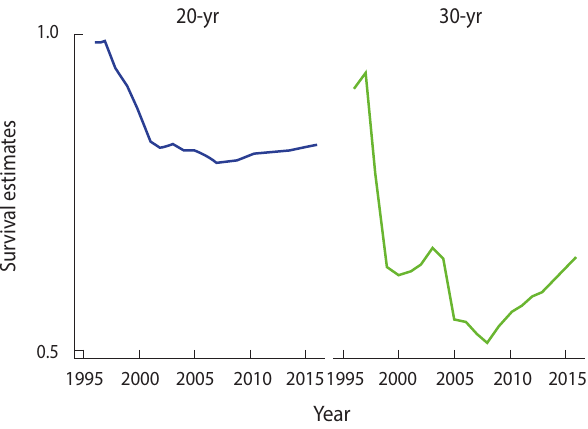
Figure 1. The 20-, and 30-year survival rates of thalassemia major patients obtained at various time intervals,